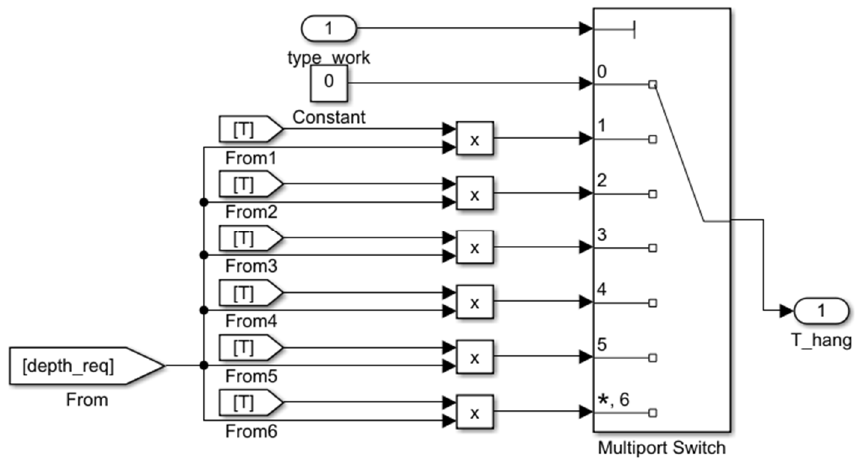
Figure 8. Suspension compensation torque